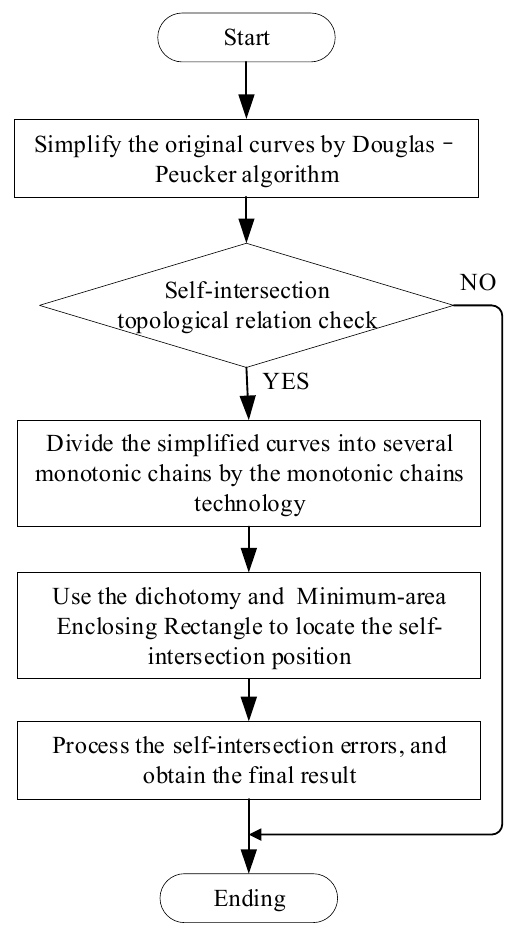
Figure 1. The flowchart of the proposed method.